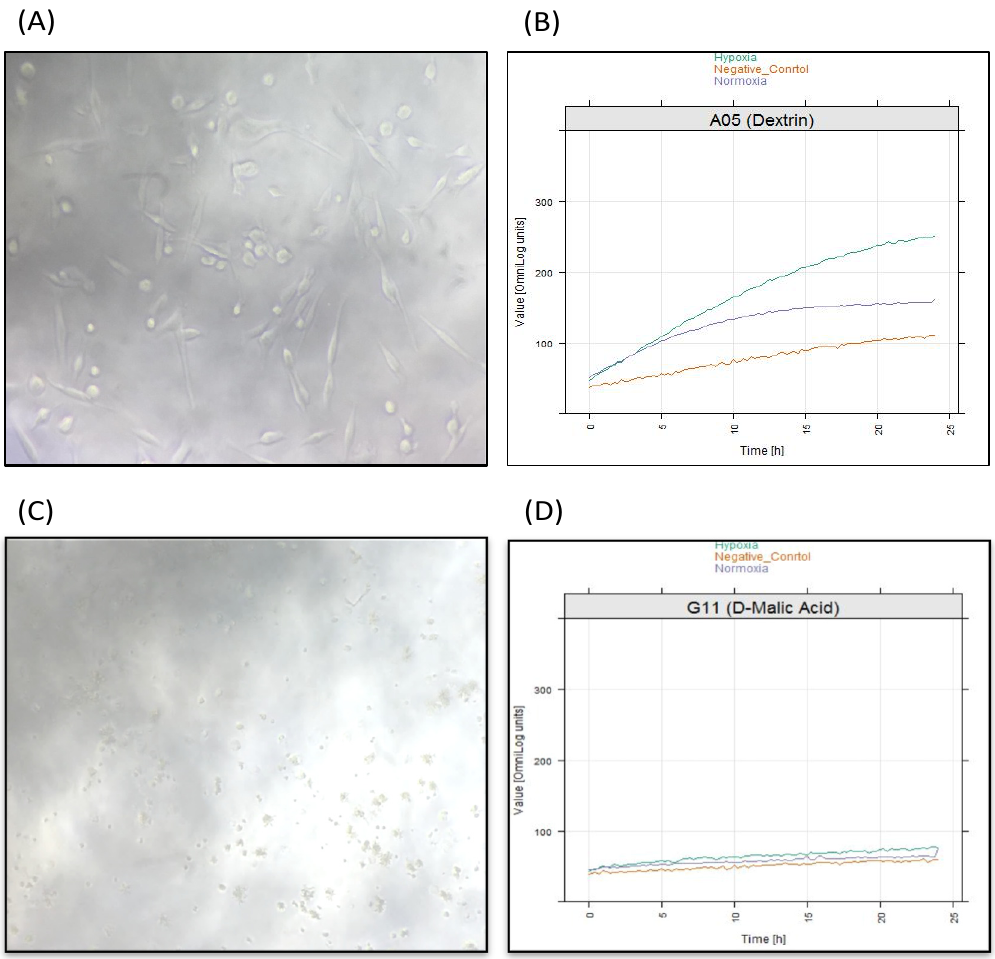
Figure 7. MDA-MB-231 cells under di ff erent chemical substrates. ( A ) Microscopic image of MDA-MB-231 cells in a well containing dextrin after 72 h of incubation shows cells were surviving well under hypoxia conditions. ( B ) Quantification of energy levels that were produced by dextrin utilization in hypoxia and normoxia conditions. ( C ) Microscopic image of MDA-MB-231 cells in well containing d -malic acid after 72 h incubation shows cells were killed under hypoxia conditions. ( D ) Quantification of energy levels produced by d -malic acid utilization in hypoxia and normoxia conditions. Scale bar = 100 μ m.